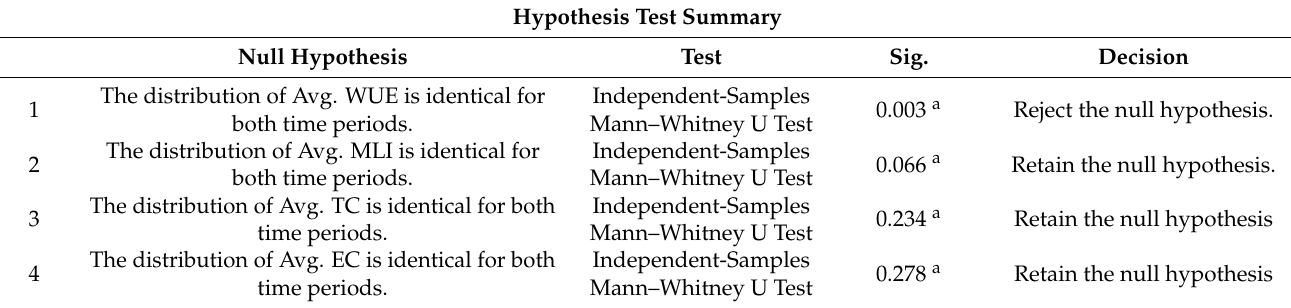
Table 5. The Mann–Whitney U table to indicate significant statistical differences between the WUE and productivity results for two time periods (2006–2011 and